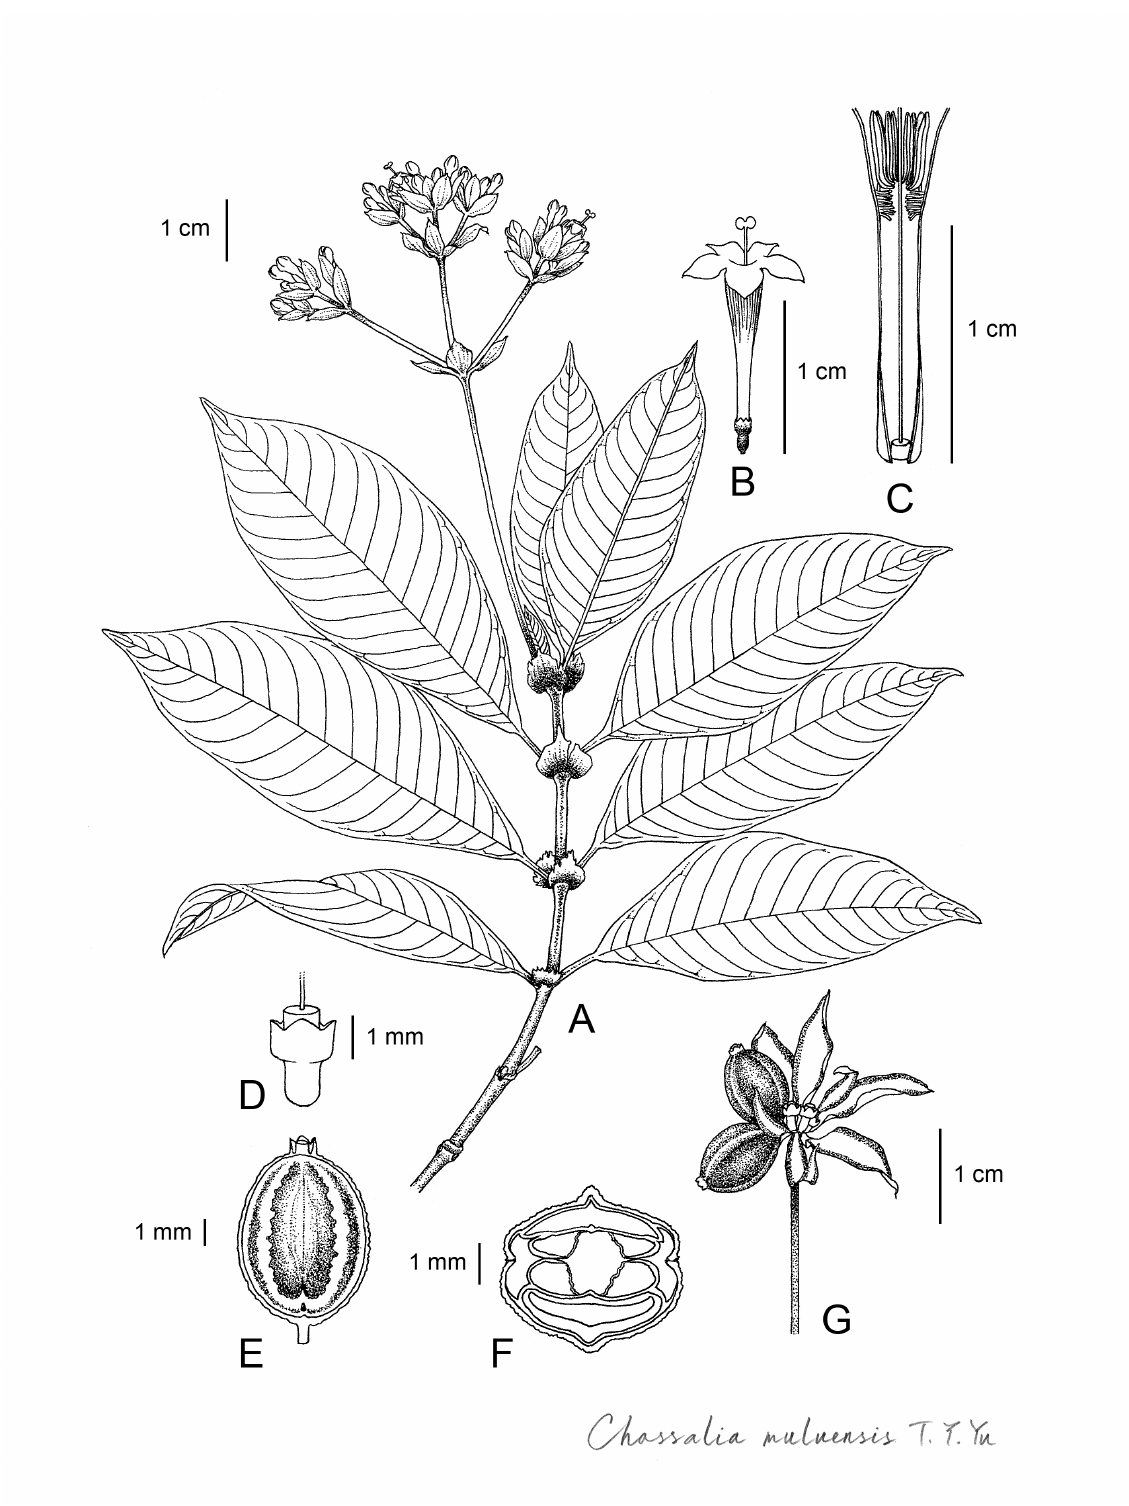
Fig. 24. Chassalia muluensis T.Y.Yu sp. nov. A . Flowering shoot. B . Flower. C . Longitudinal view of corolla tube showing stamens, band of hairs, style and disc. D . Hypanthium, calyx and disc of a flower. E . Pyrene ventral surface. F . Dry fruit transection. G . Part of infructescence, showing dry fruit. From G. Argent, B. Coppins 1134 . Drawn by T.Y.